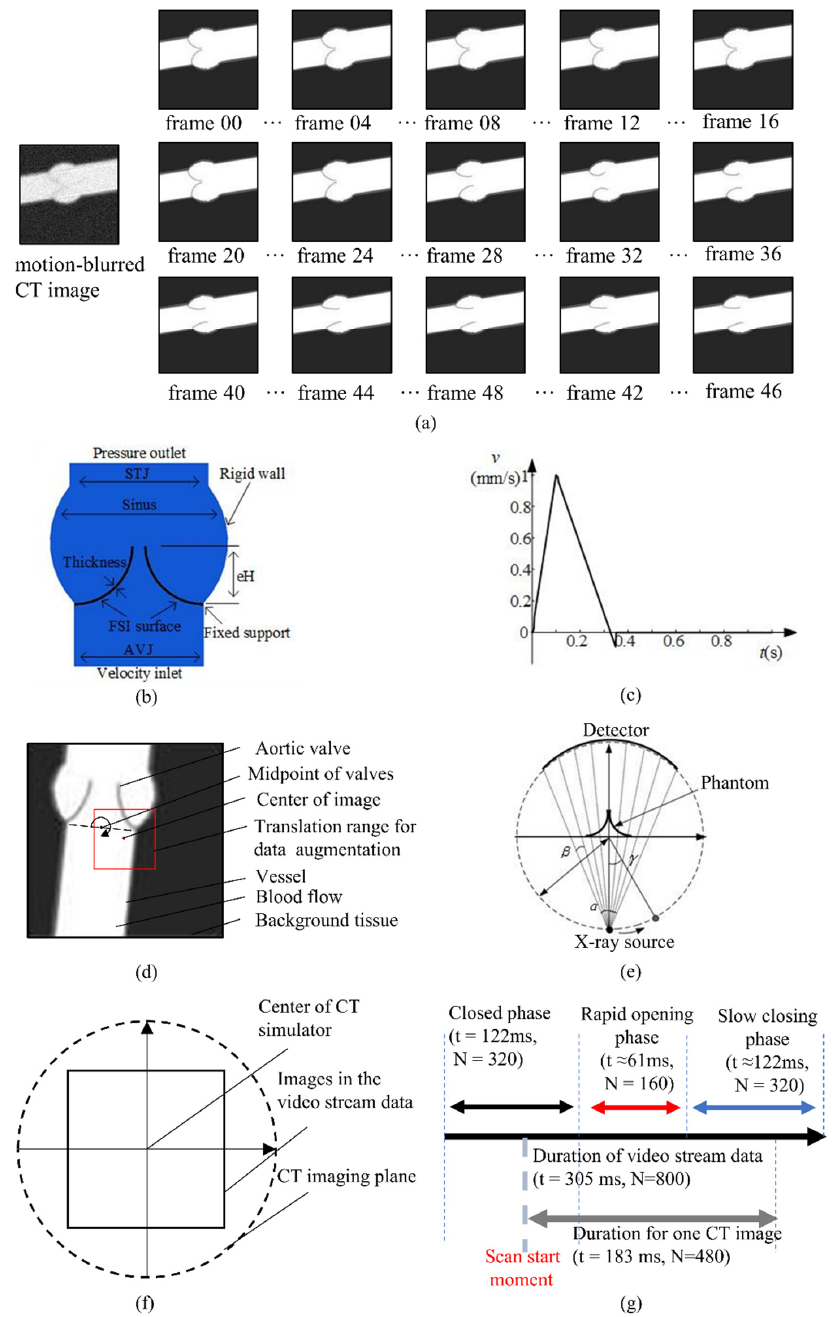
Figure 2. Data generation process. ( a ) A sample of the data. ( b ) Geometry of aortic valves. ( c ) Veloc